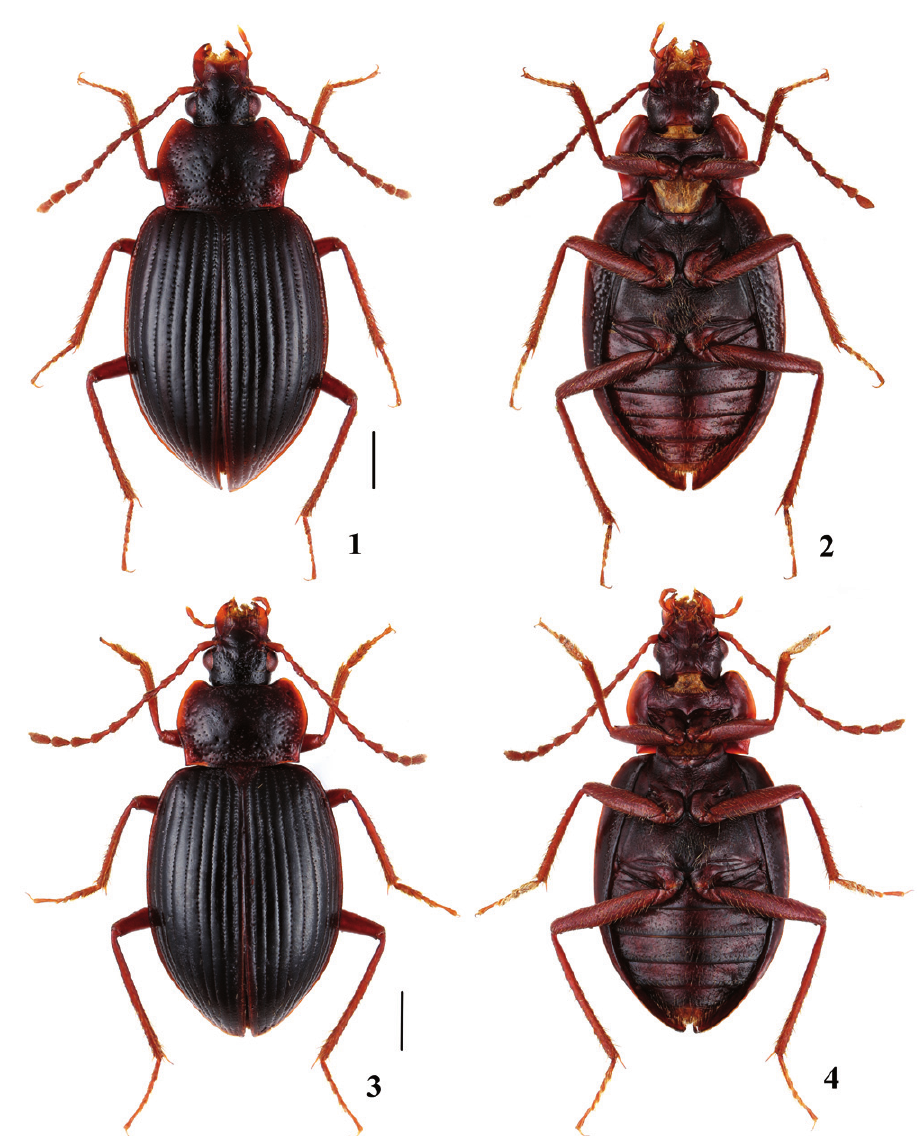
Figures 1–4. Adult of Apteroloma in dorsal and ventral view. 1, 2 A. zhejiangense sp. n. (paratype female) 3, 4 A. jinfo (male from Hubei). Scales = 1